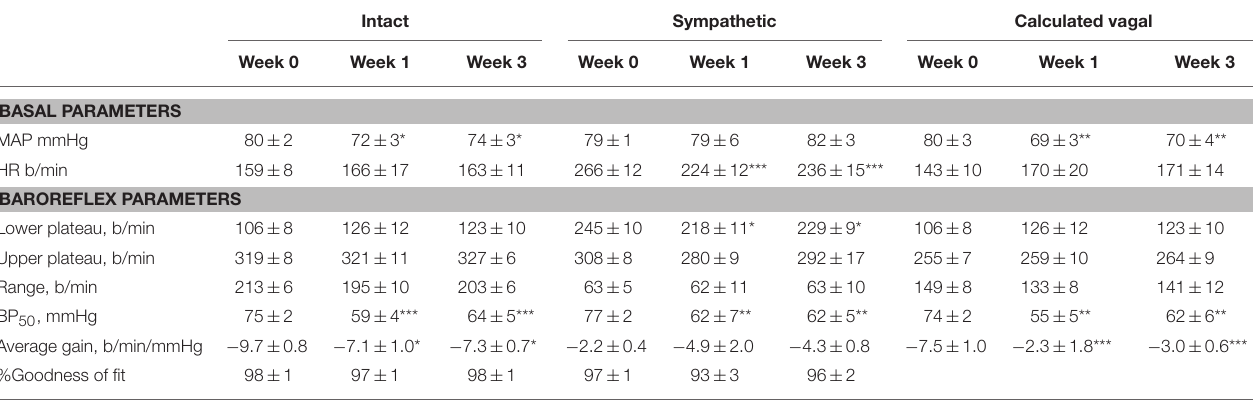
TABLE 3 | Average basal values and baroreflex parameters describing intact, sympathetic and calculated vagal MAP-HR curves before and at weeks 1 and 3 of subcutaneous administration of clonidine ( n = 7).